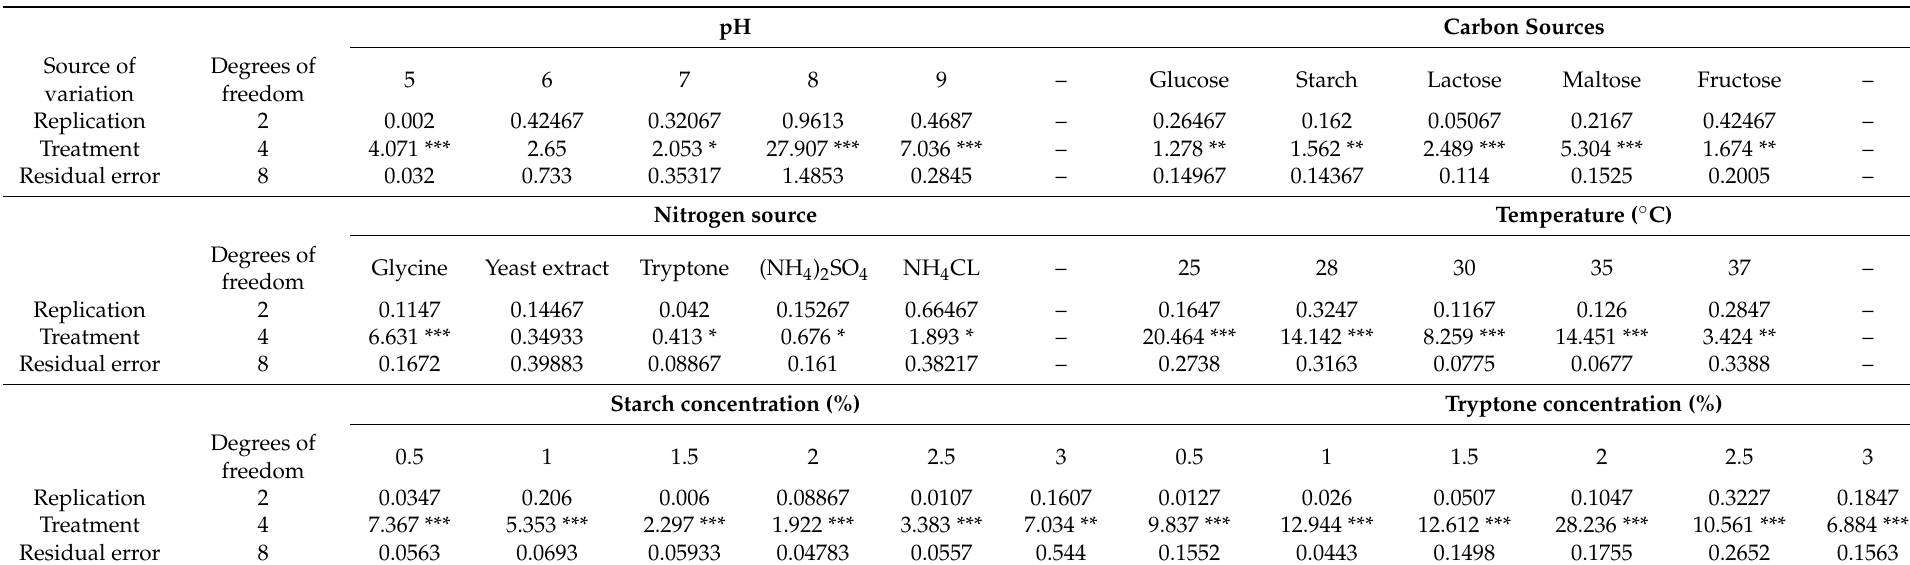
Table 2. Analysis of variance (ANOVA) for antagonistic activity of the sweet pepper fruit isolates against the R. solanacearum BD 261 pathogenic strain, at different treatment levels of pH, carbon sources and nitrogen sources, temperature, and different level of carbon and nitrogen sources (starch and